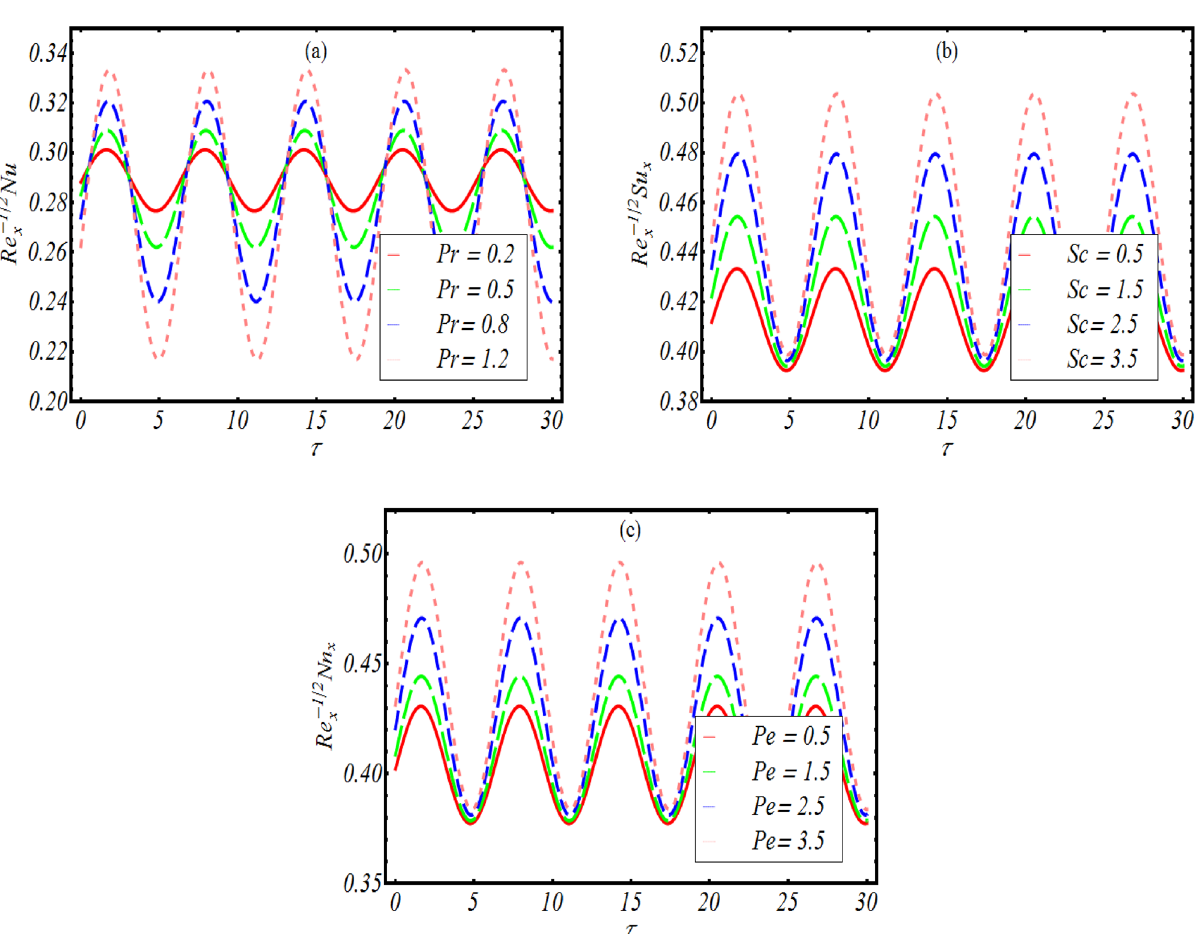
1 / 2 Pr, ( b ) variation in Re 1 / 2 x Nu x for